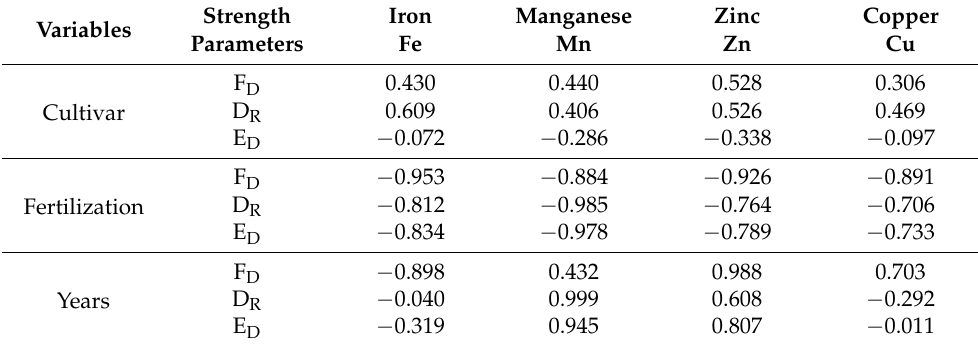
Table 7. Correlation coefficients (r) between the strength parameters of pea seeds and the content of microelements in seeds.